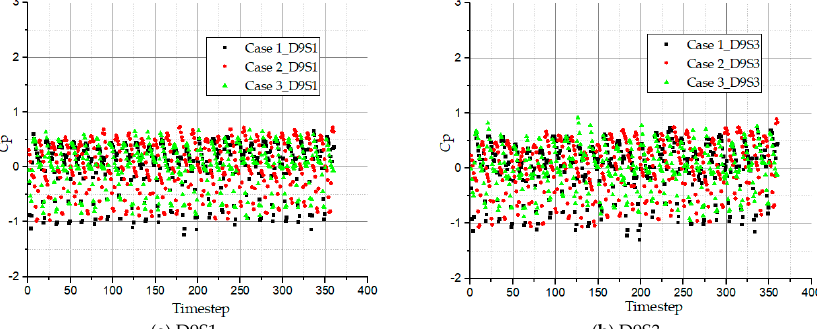
Figure 16. Time domain history of pressure fluctuation coefficient in side channel passage at outflow region for all pump cases.